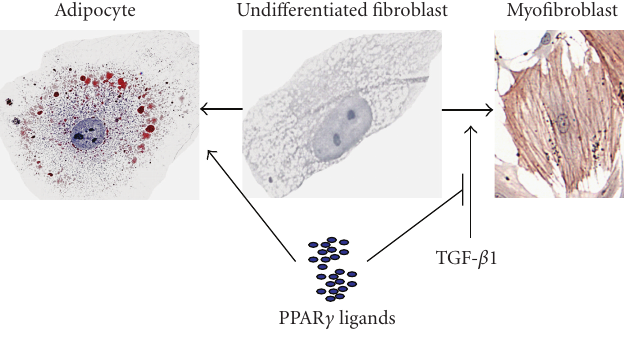
Figure 1: PPAR γ ligands promote fibroblast di ff erentiation to adipocytes and inhibit di ff erentiation to myofibroblasts . Primary human fibroblasts (center panel) can be di ff erentiated to adipocyte-like cells (left panel) by treatment with 1 μ M 15d-PGJ 2 for 8 days. Lipid droplets were visualized with oil red O staining. Alternatively, incubation with 10 ng/mL TGF- β for 3 days will di ff erentiate fibroblasts to myofibroblasts (right panel). α -SMA was detected by immunocytochemistry. Note the long bundles of contractile